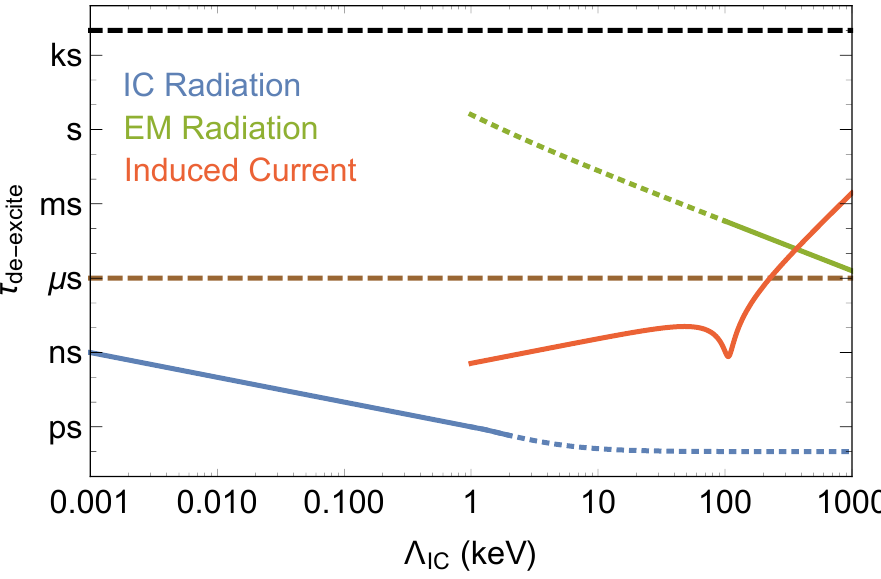
Figure 9 . The di(cid:11)erent contributions to the de-excitation time through energy loss. Below (cid:3) IC (cid:24) keV (cid:24) (cid:23)A (cid:0) 1 , the infracolor glueball radiation dominates and leads to prompt annihilation. Above 1 keV, the impact parameter becomes too large and infracolor glueball radiation ceases (indi- cated with the dotted line). Similarly, below (cid:3) IC (cid:24) 100 keV, the conductor will screen propagating waves and our calculation may not be reliable. Induced current losses dominate until & 300 keV when electromagnetic radiation losses become more important. Importantly, across the entire range, (cid:28) de-excite (cid:28) 10 4 s , where the stopped particle search begins to lose sensitivity due to very long par- ticle lifetimes [34] (below dashed black line). For (cid:3) IC & 100 keV, the stopped particle searches may become more sensitive than the results predicted here (above dashed brown